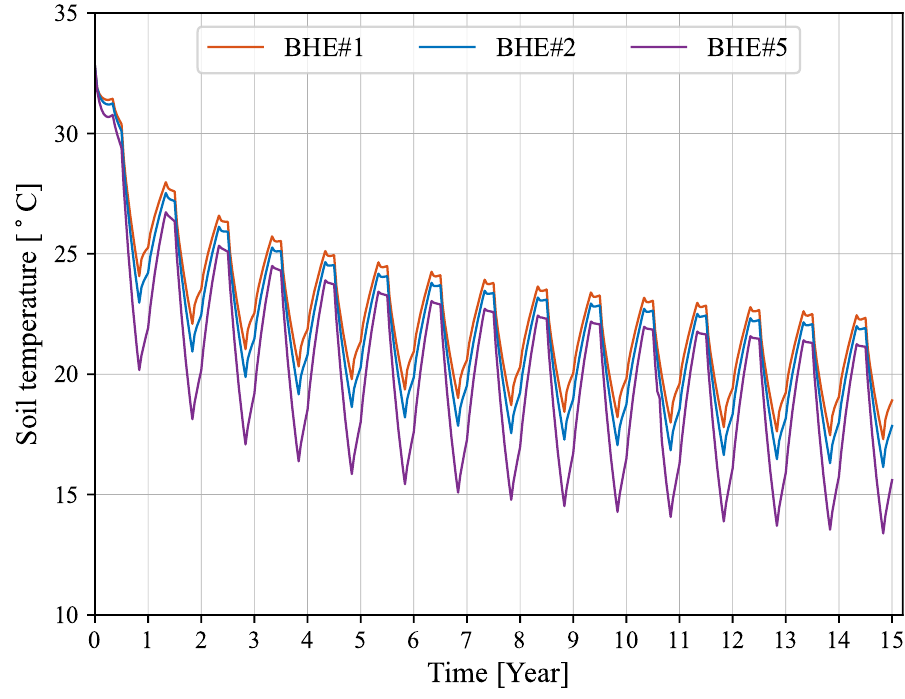
Figure 10. Evolution of soil temperature over 15 years at 1 m distance from the selected MSBHEs at a depth of 505 m in the end of cooling, heating, and recovery